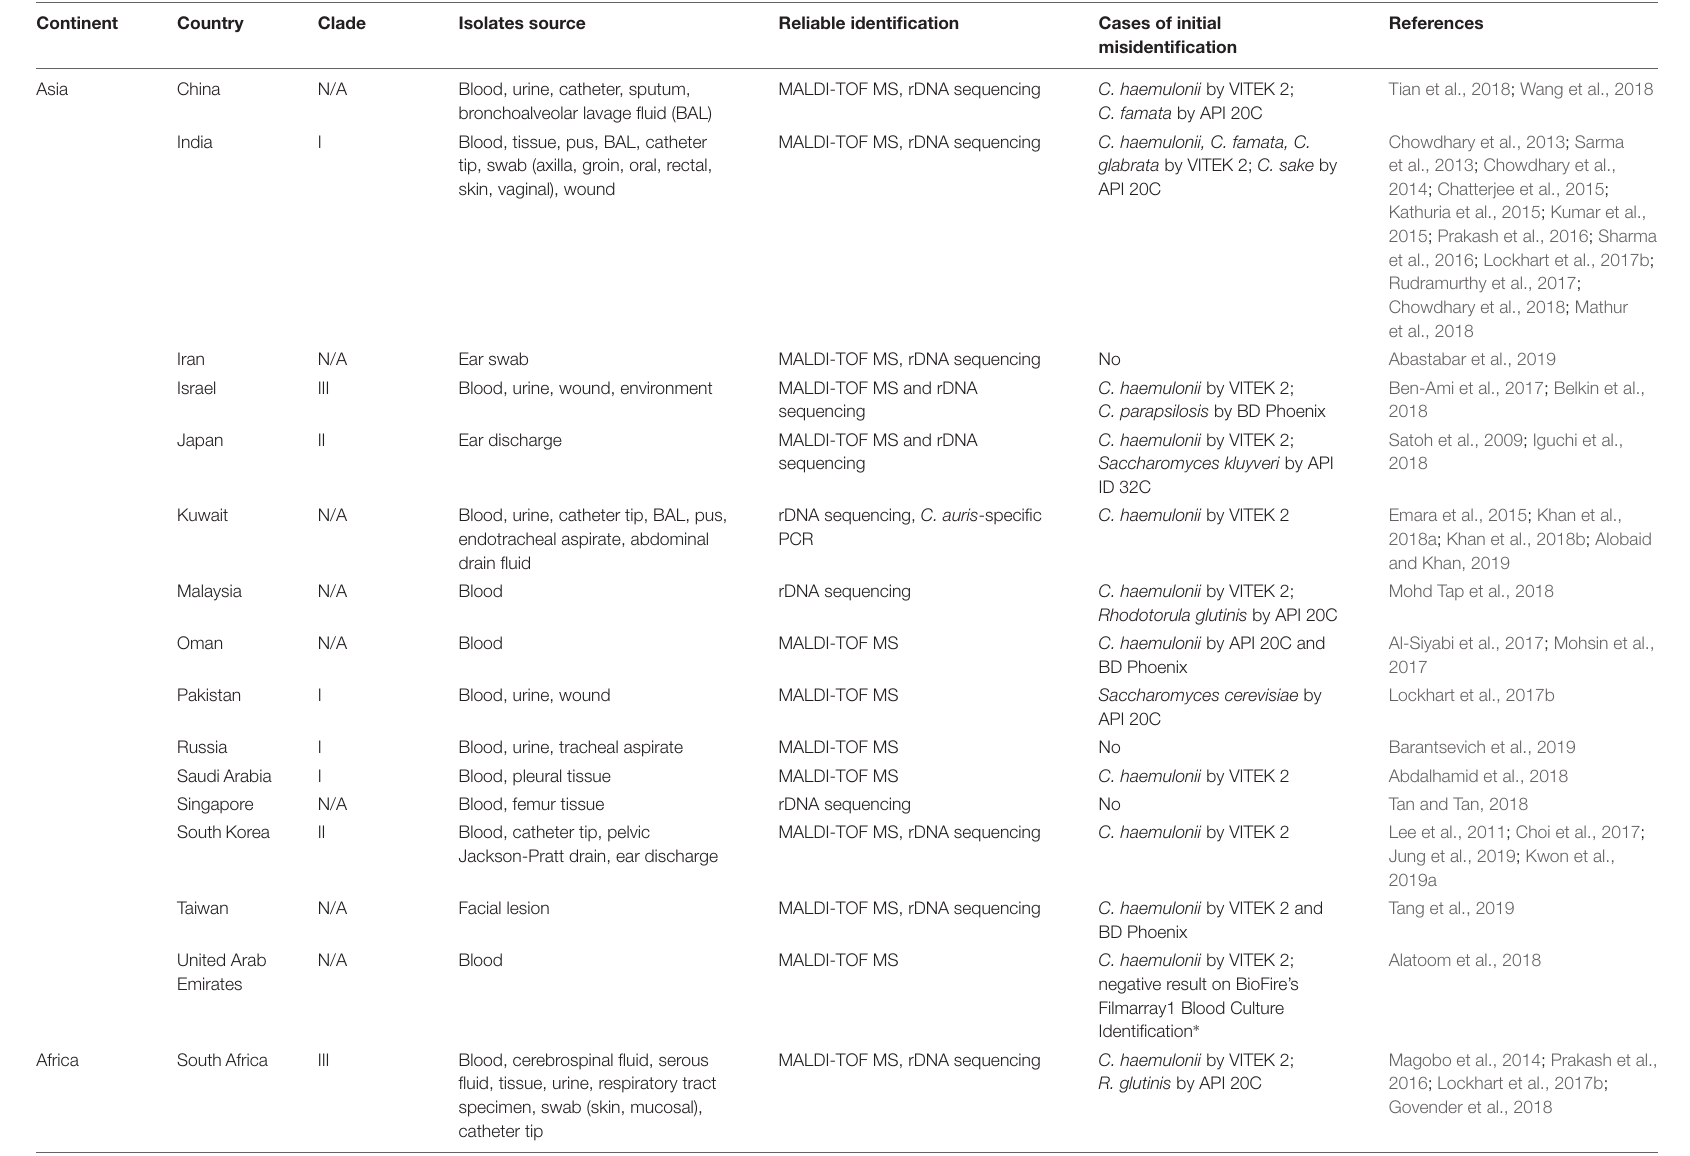
TABLE 1 | Published cases of Candida auris (as of April 01,